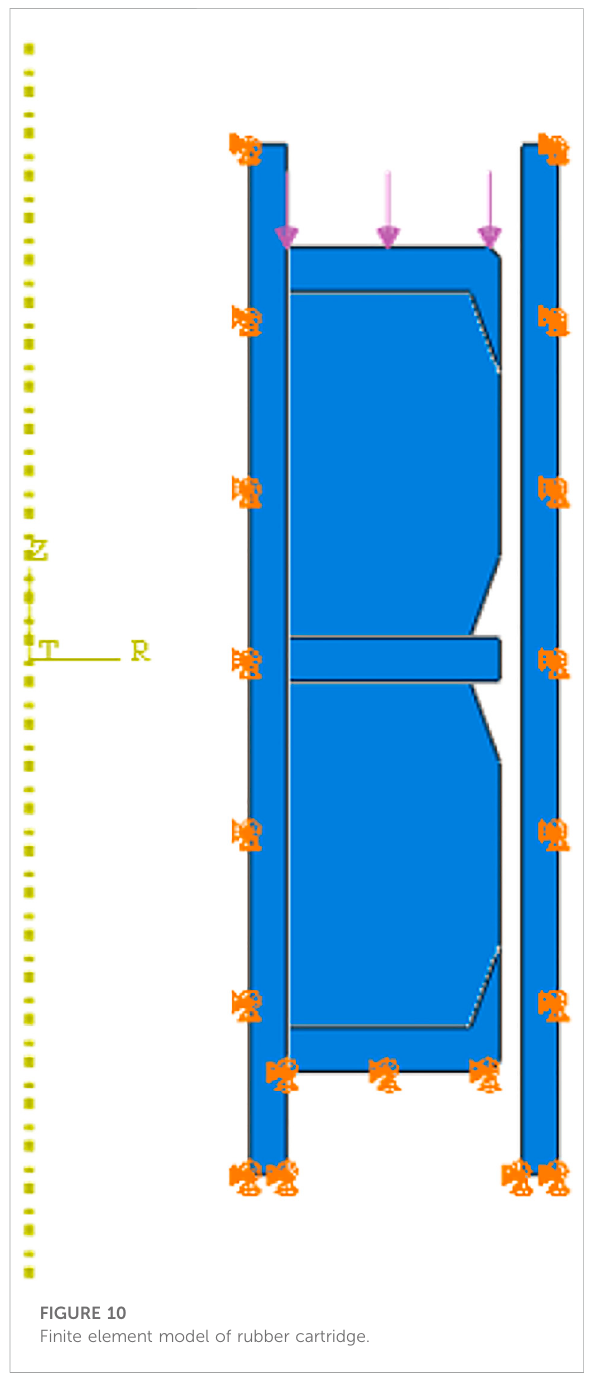
FIGURE 10 Finite element model of rubber